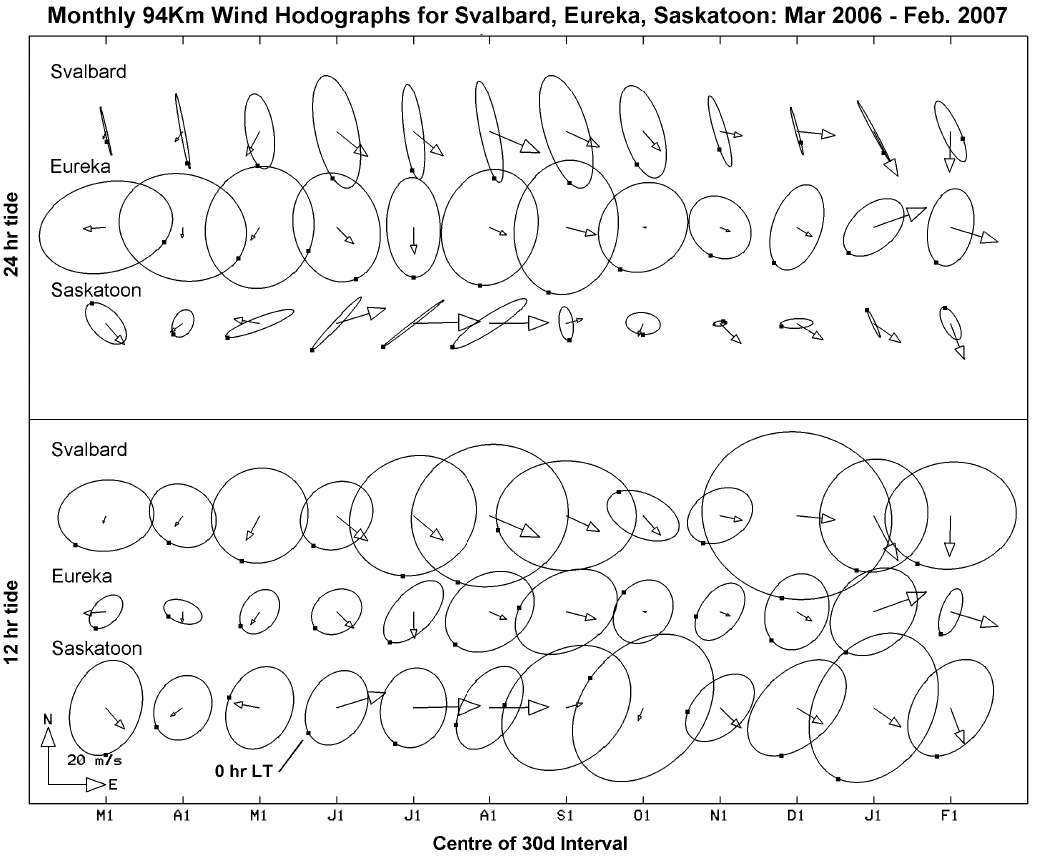
Fig. 7. Hodographs for the 24 and 12h tidal components at 94km from the Eureka and Svalbard radars along with those for the high mid- latitude MFR at Saskatoon (52N). The arrows show the monthly mean winds, and the small black squares on the hodographs indicates the position of the tidal wind vector at